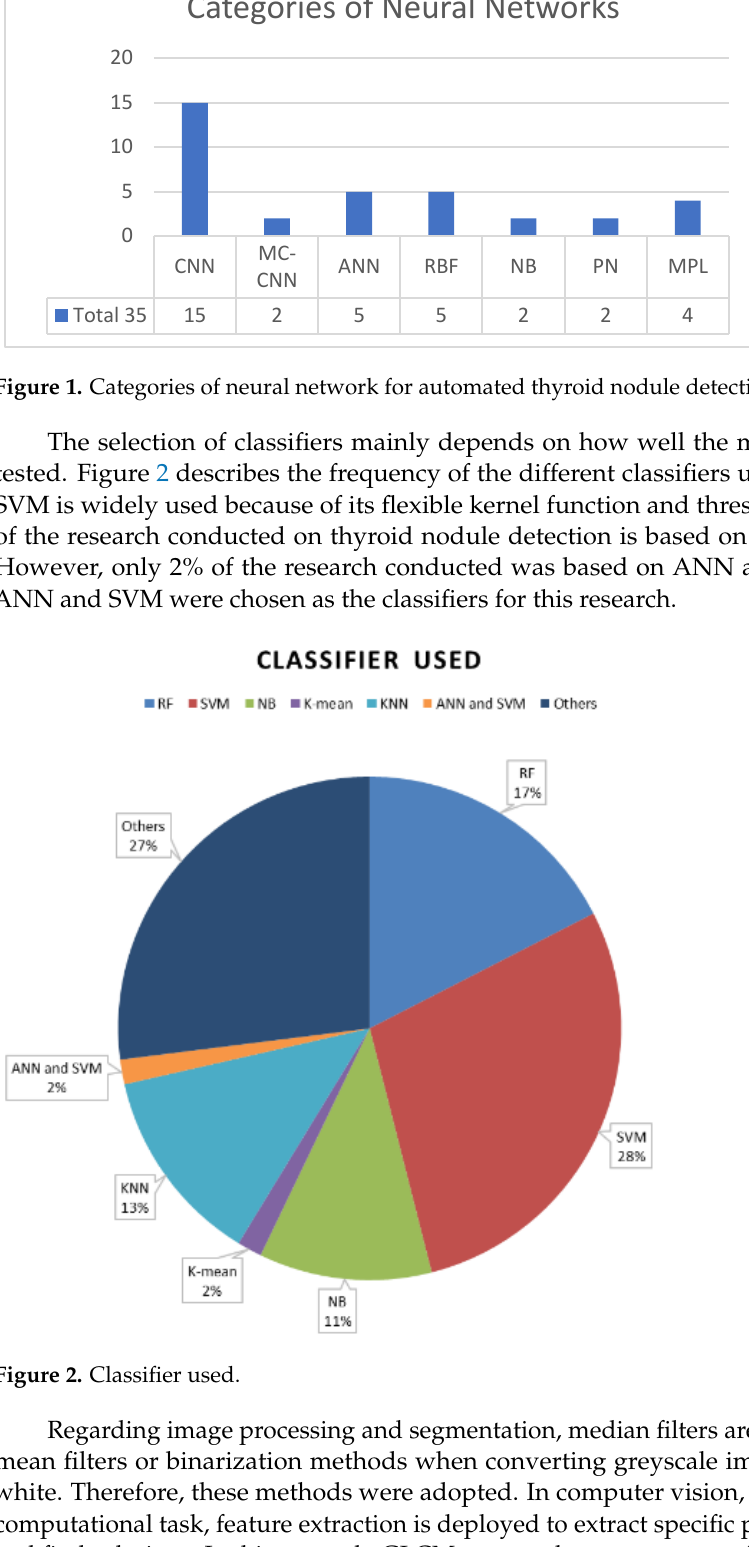
Figure 1. Categories of neural network for automated thyroid nodule detection.